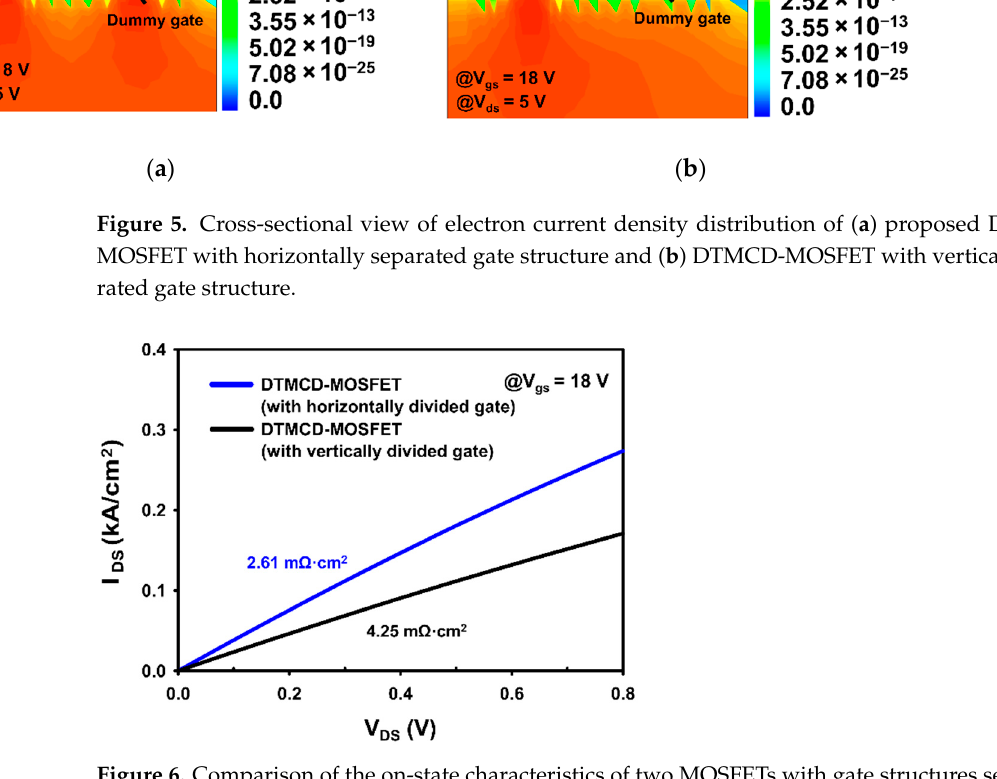
Figure 6. Comparison of the on-state characteristics of two MOSFETs with gate structures separated in horizontal and vertical directions, respectively.